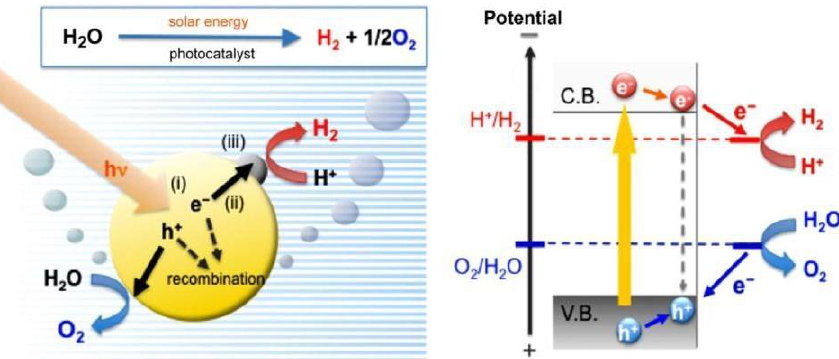
Figure 4. Schematics of photochemical water splitting [27]. Figure reused with permission from https://pubs.acs.org/doi/10.1021/cr1002326 (accessed on 1 September 2022); further permission related to this article should be directed to ACS.